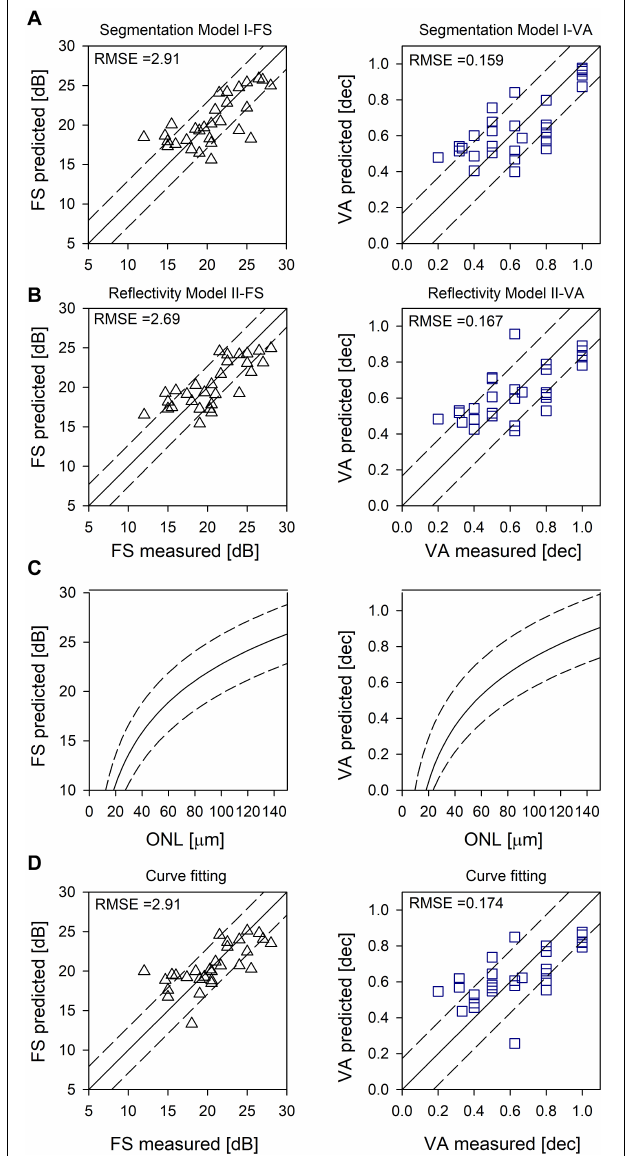
FIGURE 2 | Evaluation of the models. (A) Random forest segmentation Model I-FS and I-VA showing predicted versus measured values. (B) Random forest Model II-FS and II-VA showing predicted versus measured values. Equality line (y = x) is superimposed (solid line); RMSE are shown as dashed lines (A,B) . (C) Logarithmic curve [y = y0 + a*log(x)] fitted to FS versus ONL, and VA versus ONL (solid lines). (D) Prediction based on curve fitting. Equality line (y = x) is superimposed (solid line). RMSE are shown as dashed lines (C,D)